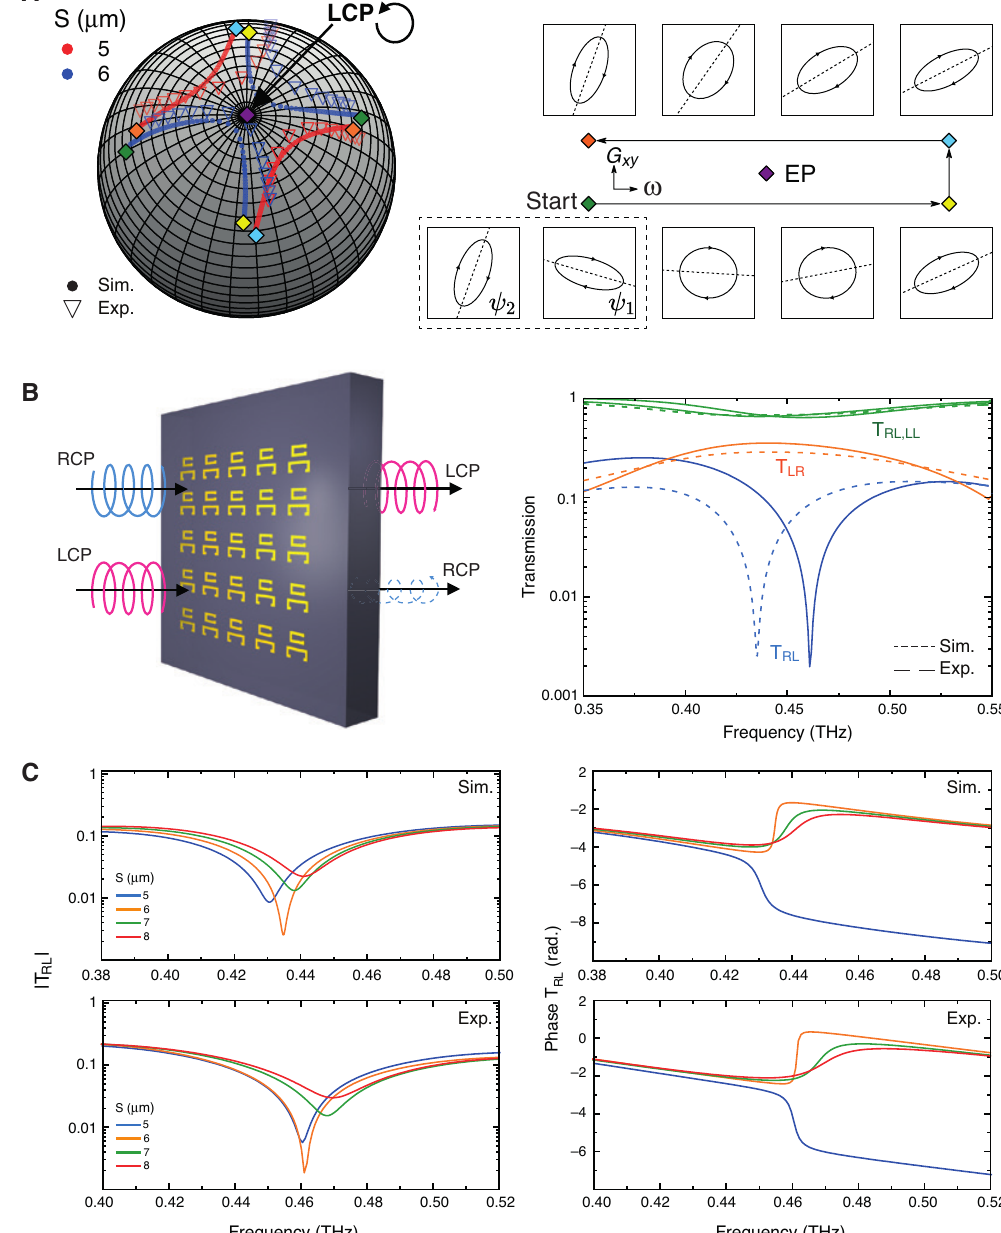
Figure 3: Eigenstate swapping and transmission phase singularity observed by changing coupling between resonator components. (A) Transmission eigenstates of the metasurface are plotted on a Poincaré sphere as the EP is encircled in the [ ω , G ( S )] parameter space. Under xy one full loop around the EP, the states move halfway around the north pole of the Poincaré sphere, resulting in a swapping of eigenstates [i.e. ( ψ , ψ ) → ( ψ ,- ψ )]. To the right of the Poincaré sphere, we explicitly show the evolution of polarization states. The states in the dashed box show 1 2 2 1 the two eigenstates at the beginning of the loop. Thereafter, we follow how state ψ evolves and find that it becomes ψ at the end of a single 1 2 loop. (B) The transmission matrix components in the circularly polarized basis are shown when S = 6 μ m. As we have anticipated from Eq. (5), T and T are identical, whereas T is suppressed with respect to T . The asymmetric transmission of circularly polarized light is a direct RR LL RL LR consequence of having a single eigenstate at the EP. (C) An abrupt phase flip in T is observed as the parameter S is modulated through the RL